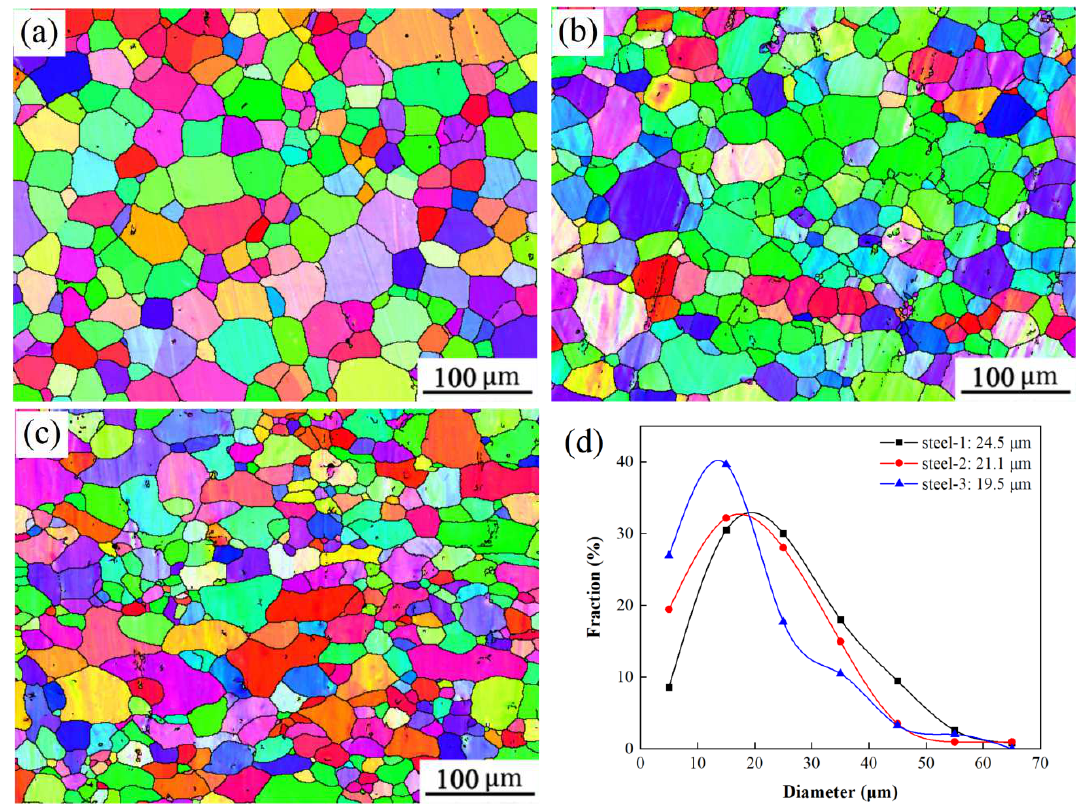
Figure 2. Morphology ( a – c ) and size distribution ( d ) of ferrite grains in three ferritic stainless steels: ( a ) steel-1, ( b ) steel-2, ( c ) steel-3, and ( d ) average ferrite grain size and its distribution.